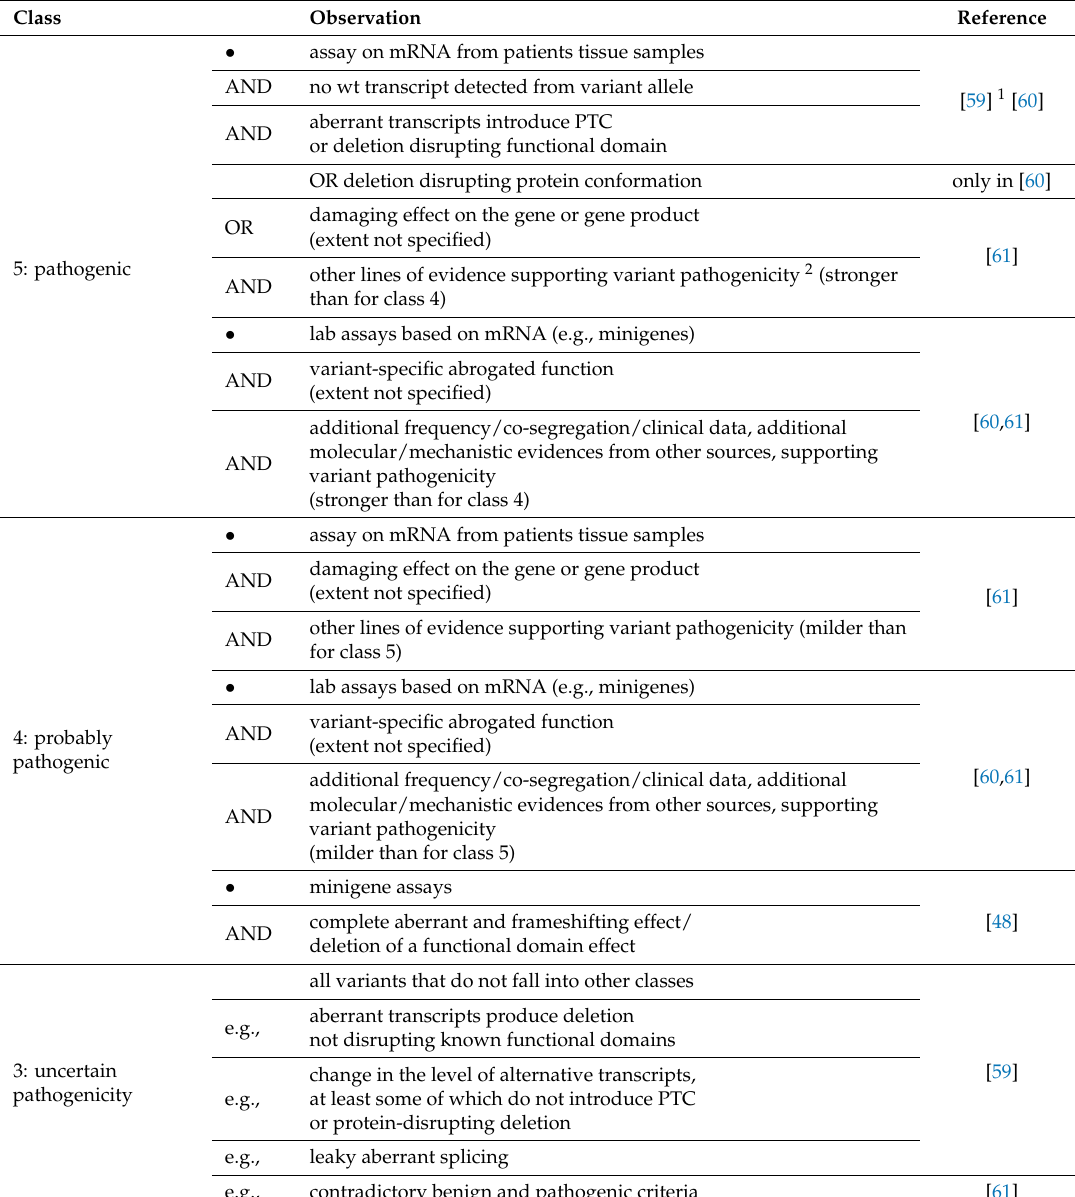
Table 4. Summary of clinical classification guidelines that apply to SRE-affecting